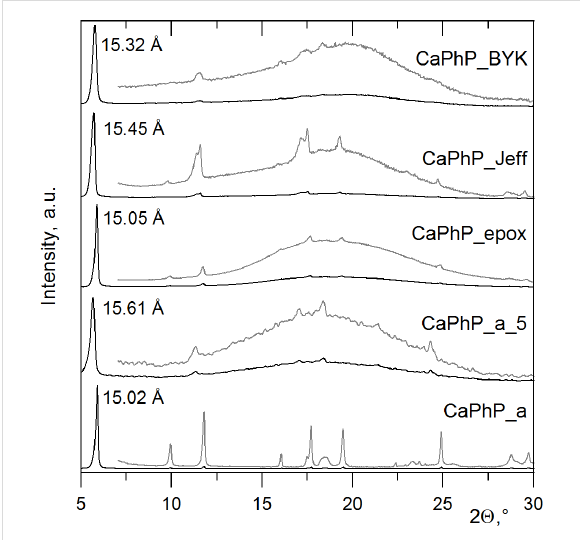
Figure 8: XRD patterns of original calcium phenylphosphonate (CaPhP_a), free film with 5 wt % of CaPhP as filler (CaPhP_a_5) and its blends with CHS-EPOX 520 (CaPhP_epox), curing agents Jeffamines (CaPhP_Jeff) and with dispersing agent BYK 9076 (CaPhP_BYK). The gray lines show the diffraction patterns with pro- nounced intensity of the peaks other than the (001) peak.